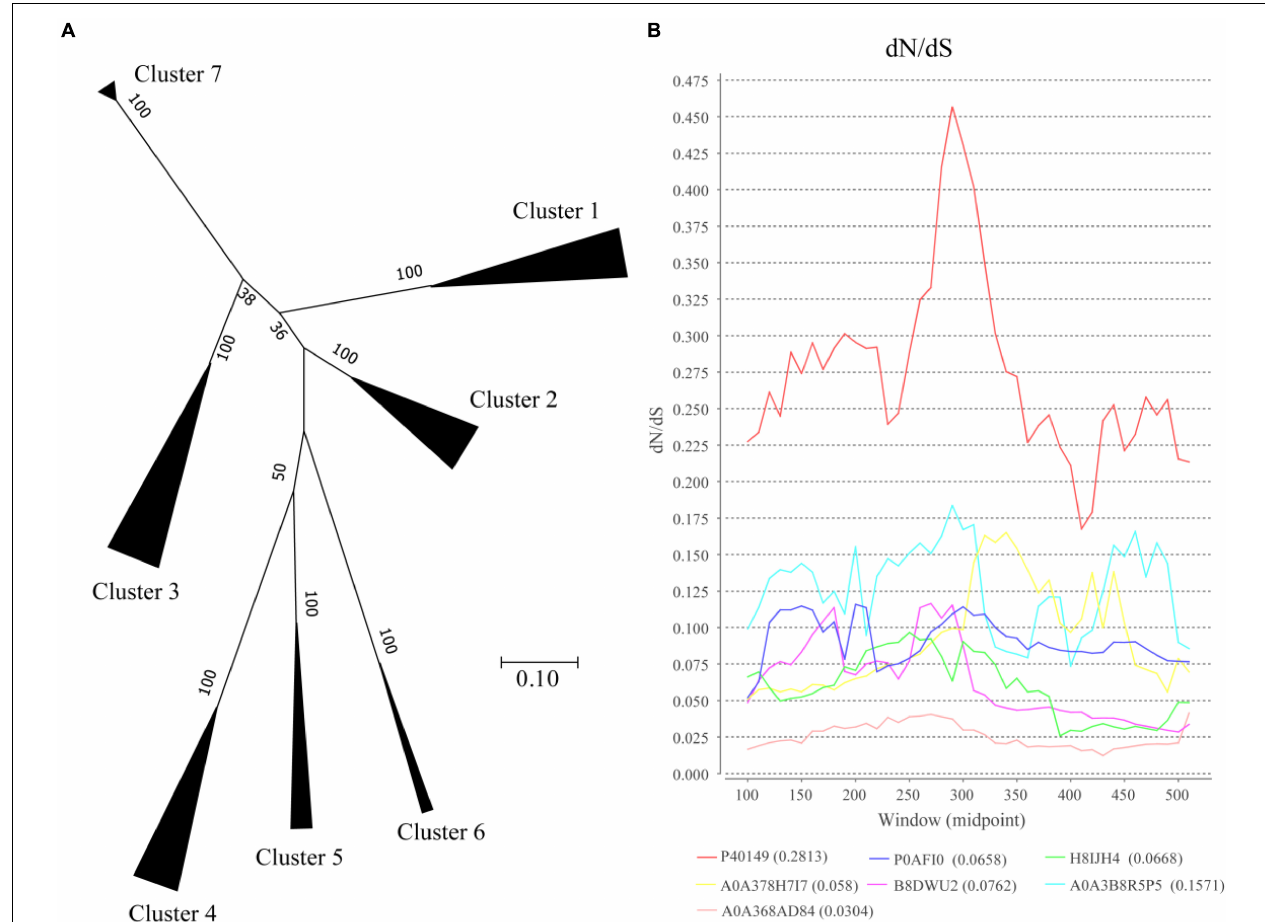
FIGURE 3 | Evolutionary analysis of oxalyl-coenzyme A decarboxylase (OXC). (A) Phylogenetic analysis of the oxalyl-coenzyme A decarboxylase (OXC) family. Unrooted maximum likelihood phylogenetic tree of OXC proteins. All taxa from each group in Figure 1 were clipped from the tree and replaced by a triangle, whose width is proportional to the number of taxa in that group. The numbers at the branches are confidence values based on bootstrap method calculated using 1000 bootstrap replications. The scale bar in the figure represents 0.2 substitutions per site. (B) dN/dS analysis of OXC of 7 enzymes from the 7 clusters as shown by sliding-window. The dN/dS rate of different clusters are shown at the bottom of the figure. The Uniprot ID of these enzymes were listed in the end of the figure. The corresponding strains of the enzymes are: P40149: Oxalobacter formigenes (Cluster 1), P0AFI0: Escherichia coli (Cluster 2), H8IJH4: Mycobacterium intracellulare (Cluster 3), A0A378H7I7: Lactobacillus acidophilus (Cluster 4), B8DWU2: Bifidobacterium animalis (Cluster 5), A0A3B8R5P5: Porphyromonadaceae bacterium (Cluster 6), A0A368AD84: Acetobacter sp. BCRC 14118 (Cluster